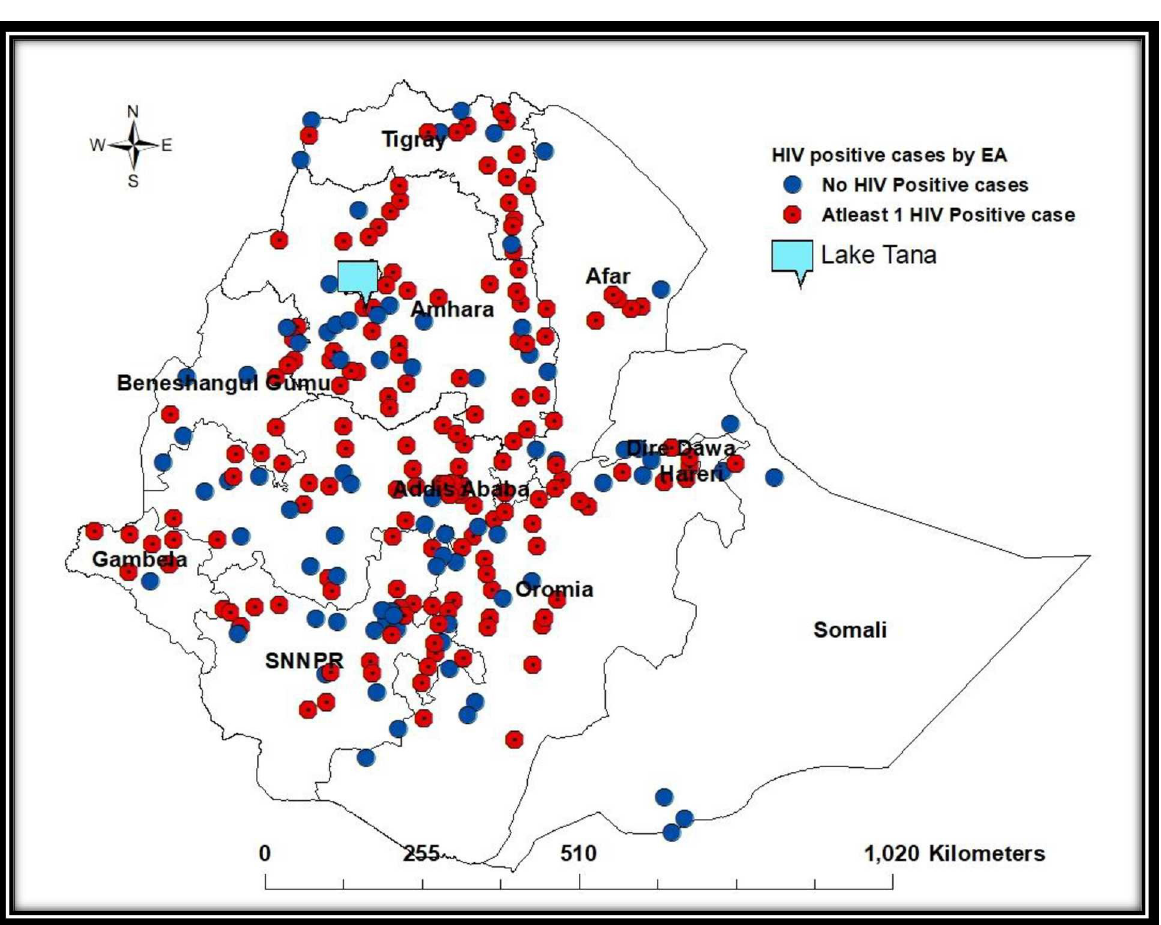
Fig 3. Distribution of HIV positive cases by enumeration areas, Ethiopia Population-based HIV Impact Assessment Survey (2017–2018).